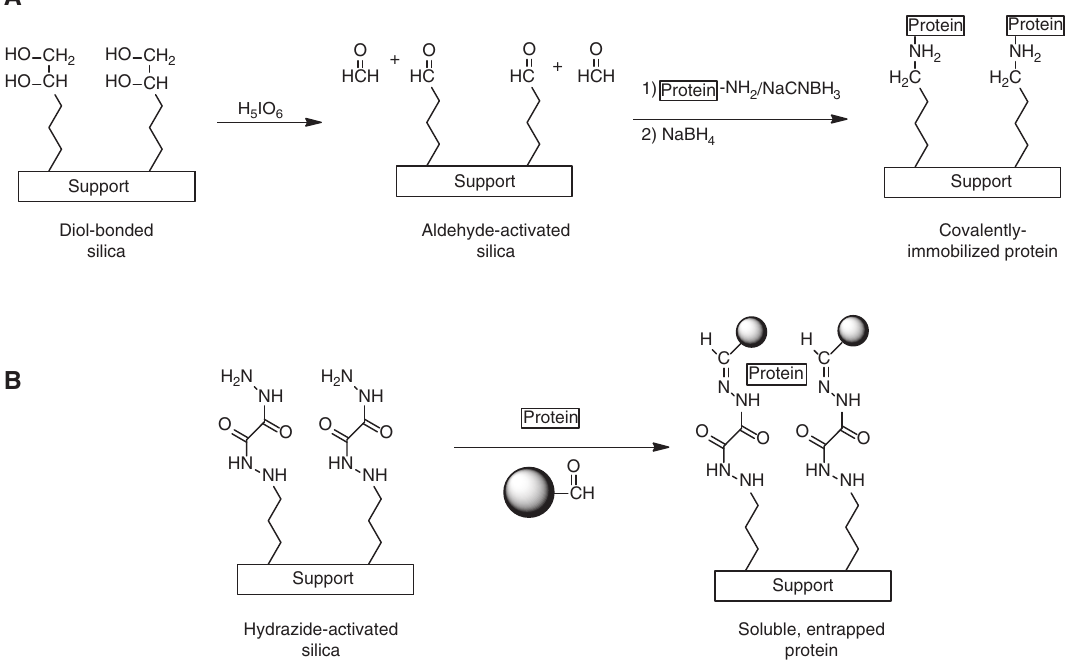
Figure 5 General reactions involved in the immobilization of a protein onto silica by (A) the Schiff base method or (B) entrapment based on the reaction of mildly oxidized glycogen with a hydrazide-activated